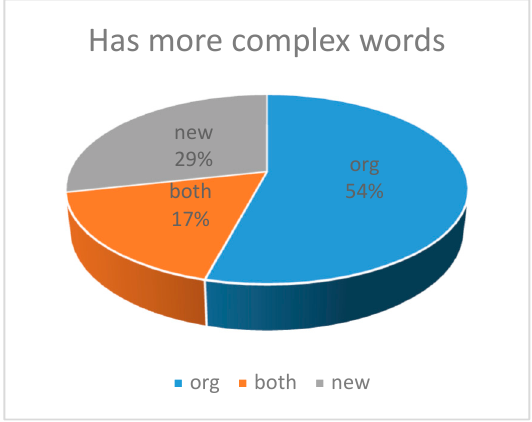
Figure 20. The result of the question: which of the two comments has more complex words? Where “org” is the original comment from the sample.